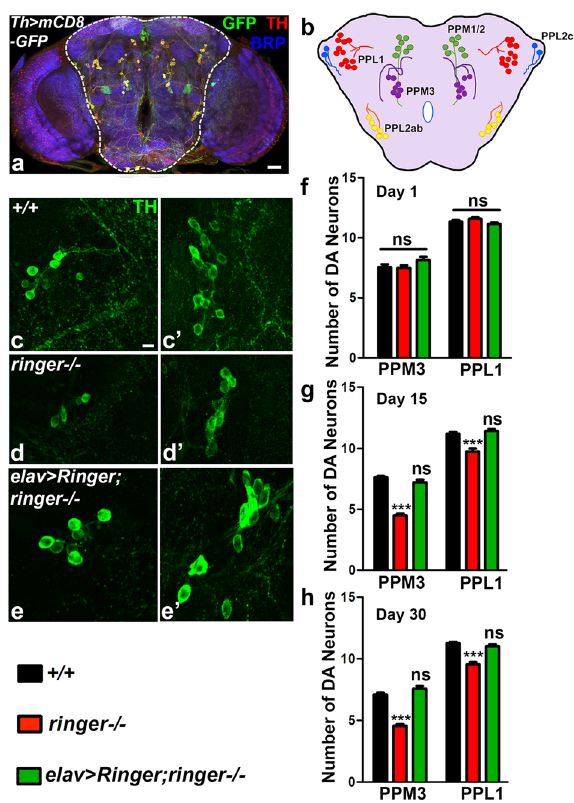
Figure 7. Ringer mutants show progressive loss of dopaminergic neurons. ( a - b ) Adult brain immunostaining ( a ) with anti-TH (red), anti-GFP (green) and anti-Brp (blue) of Th > mCD8-GFP and corresponding schematic ( b ) showing distinct DA neuron clusters on the posterior brain. ( c - e’ ) Higher magnification confocal images of PPM3 ( c - e ) and PPL1 ( c’ - e’ ) clusters stained with anti-Th (green) of day 15 wild type ( c , c’ ), ringer −/− ( d, d’ ), and ringer rescue as seen in elav > Ringer;ringer −/− ( e , e’ ). ( f – h ) Quantification of numbers of DA neurons in specified clusters of day 1 ( f ), day 15 ( g ) and day 30 ( h ) flies per brain hemisphere. n = 12 brains (~ 24 brain hemispheres) for each genotype. Statistics was done using two-way ANOVA. ( f ) day 1 PPM3 ringer −/− p = 0.9789, elav > Ringer;ringer −/− p = 0.7930, PPL1 ringer −/− p = 0.9509, elav > Ringer;ringer −/− p = 0.9958. ( g ) day 15 PPM3 ringer −/− *** p < 0.0001, elav > Ringer;ringer −/− p = 0.4653, PPL1 ringer −/− *** p < 0.0001, elav > Ringer;ringer −/− p = 0.9969. ( h ) day30 PPM3 ringer −/− *** p < 0.0001, elav > Ringer;ringer −/− p = 0.3161, PPL1 ringer −/− *** p < 0.0001, elav > Ringer;ringer −/− p = 0.7670. Scale bar: ( a ) = 20 µm, ( c - e’ ) = 5